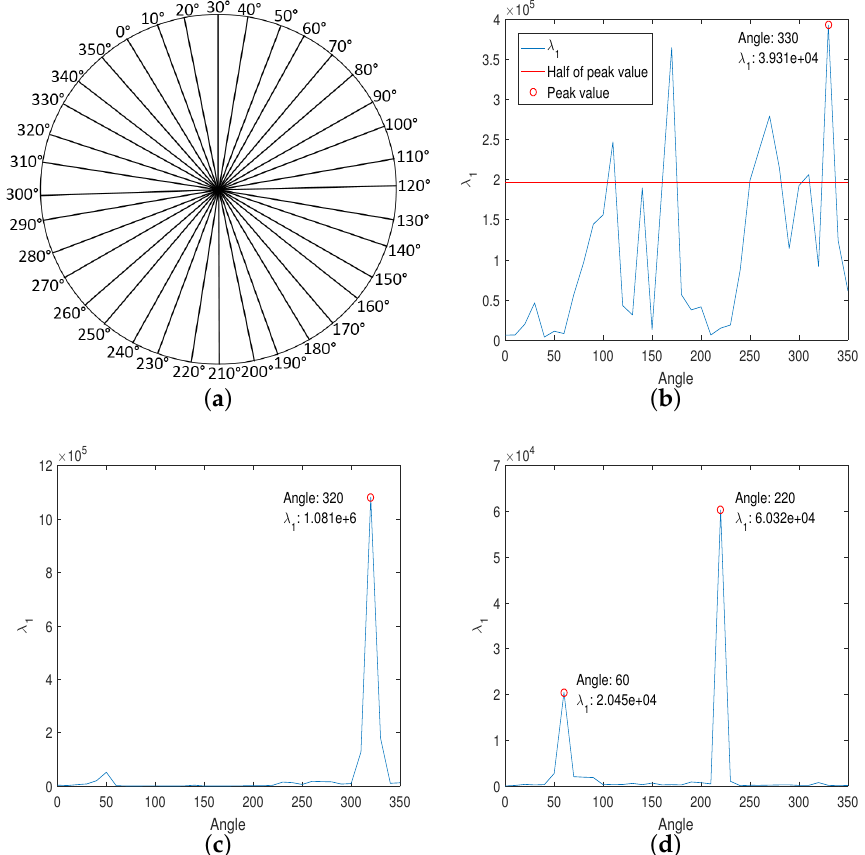
Figure 7. ( a ) Direction of each sub-aperture; together with variations of λ 1 across sub-apertures of: ( b ) target 2; ( c ) the left wall of target 6; and ( d ) target